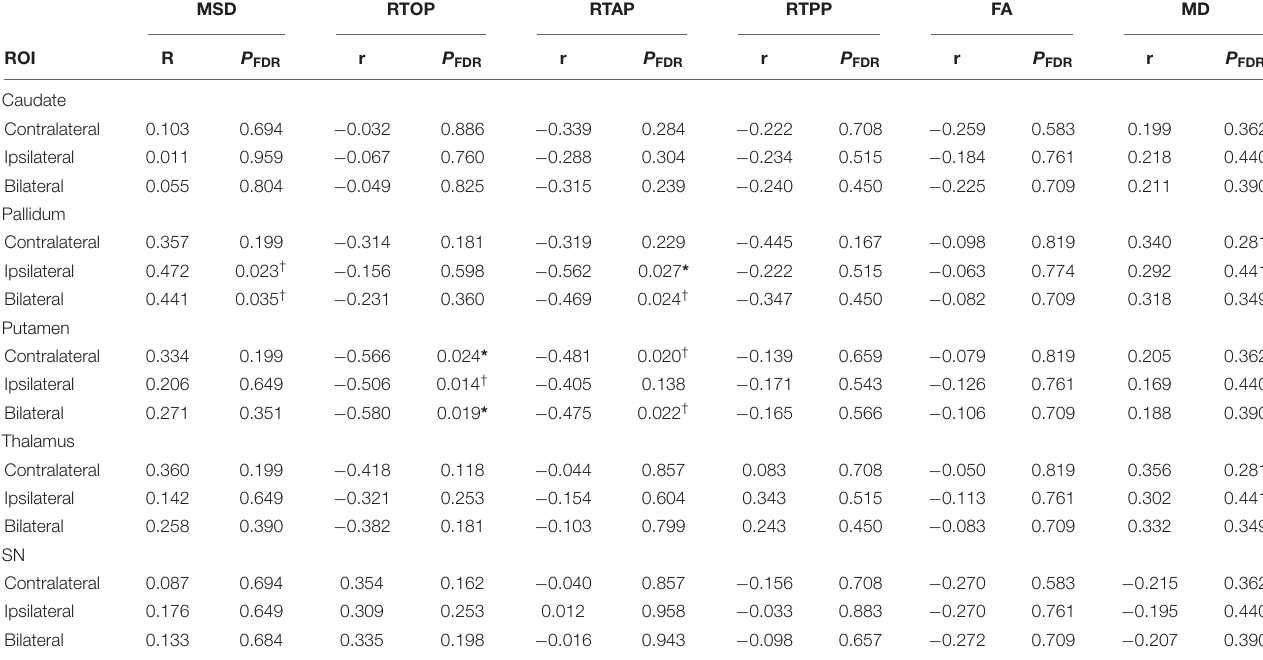
TABLE 4 | Pearson correlation analysis between parameters values and UPDRS III